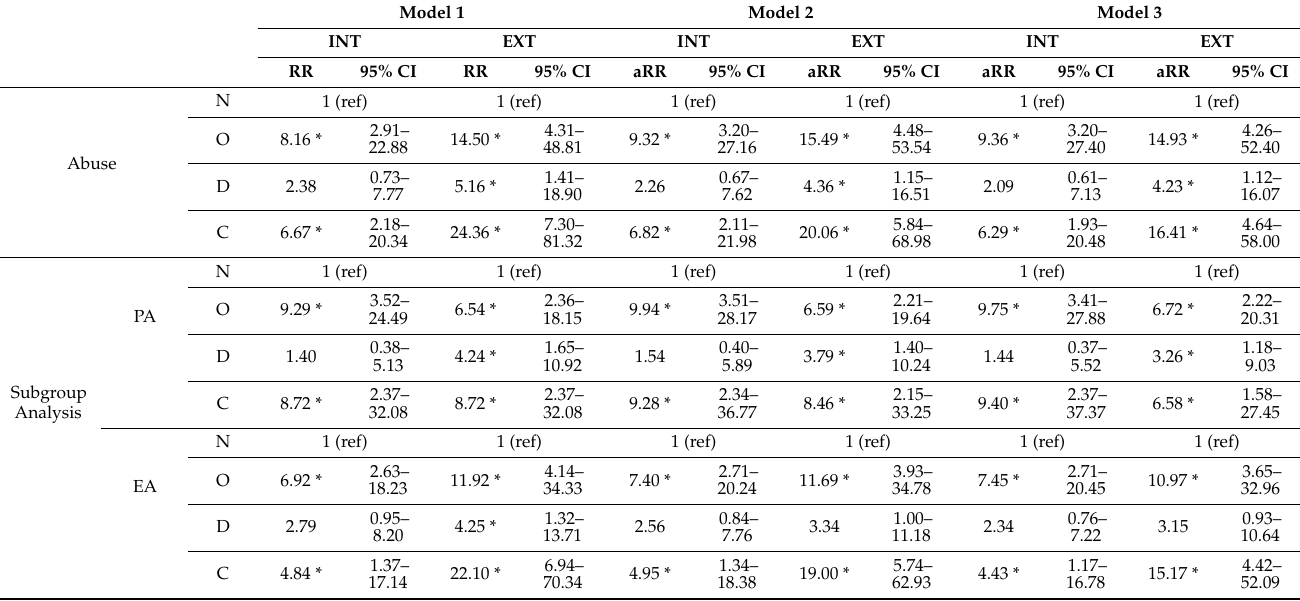
Table 4. Logistic regression analysis between variation of abuse and psychopathology at follow-up.